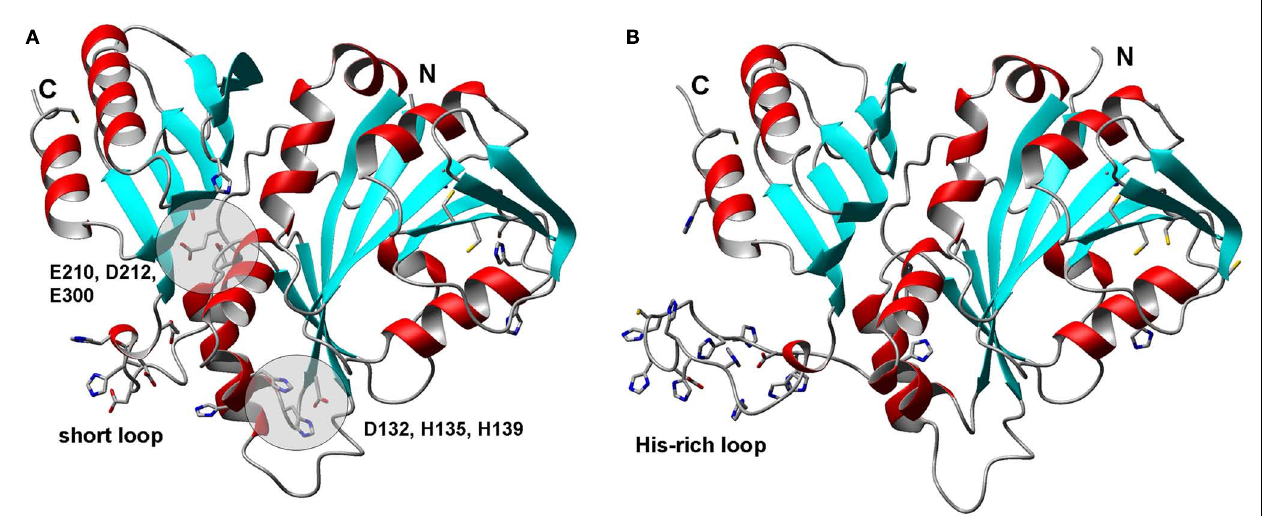
side.The cysteines forming CCXC motifs in the GTPase domain are also shown; their location in a β -strand makes their involvement in metal-binding unlikely in these structures, as their sulfurs are too far apart. C69 and H34 in B0CCJ8_ACAM1 are within > 4Å of each other, but no other potential metal-binding residues are